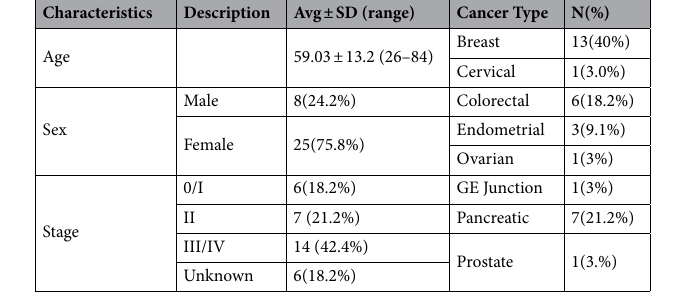
Table 1. Patient demographics and cancer